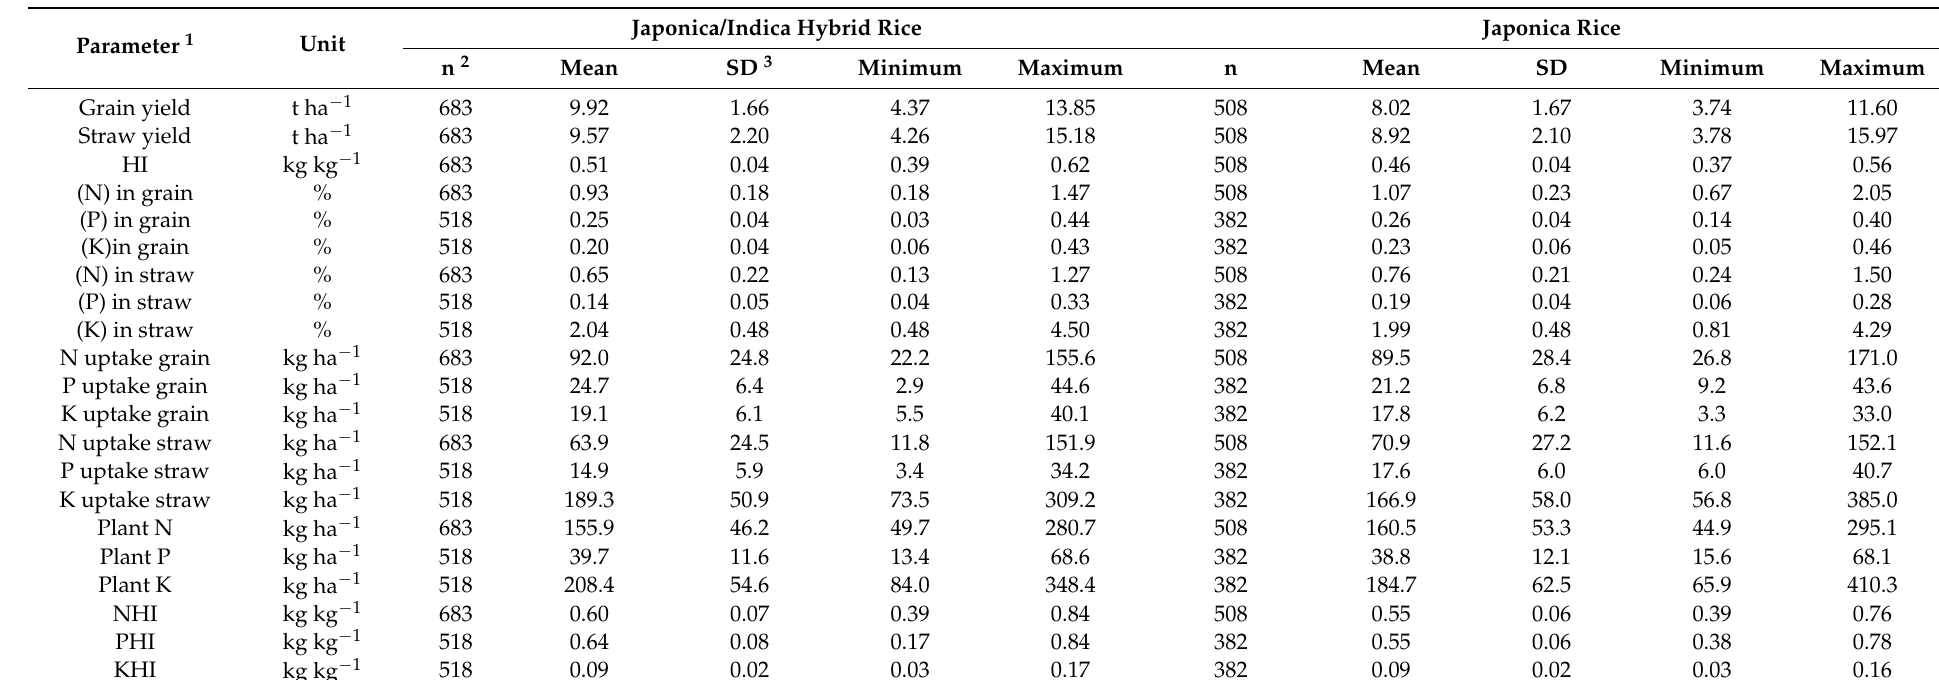
Table 1. Characteristics of grain yield and nutrient uptake of japonica/indica hybrid rice and japonica rice. Parameter